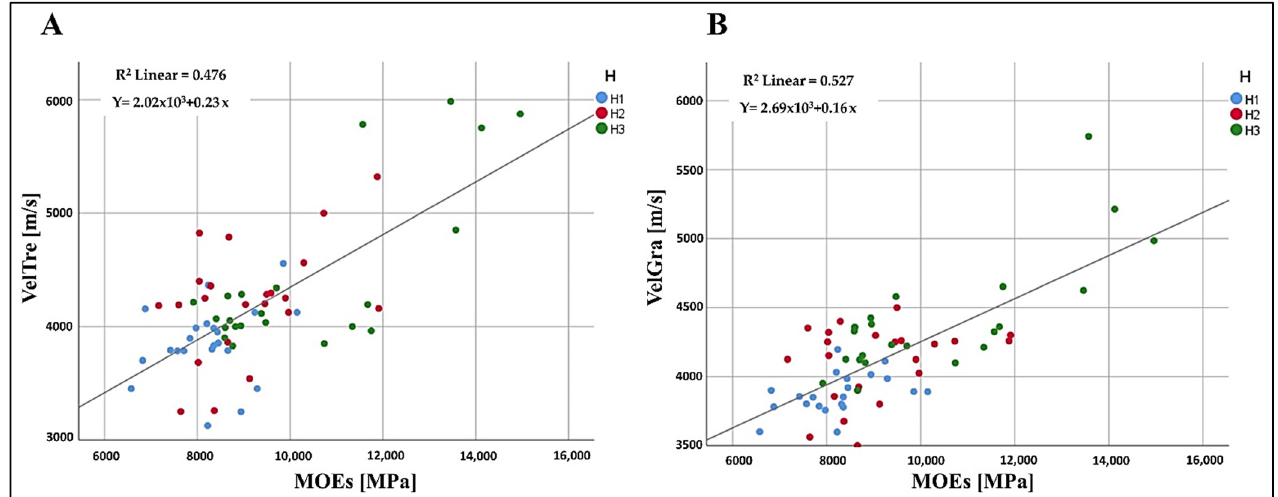
Figure 4. The relationships between the static modulus of elasticity and the sound wave stress velocities acquired from standing trees ( A ) and logs ( B ).